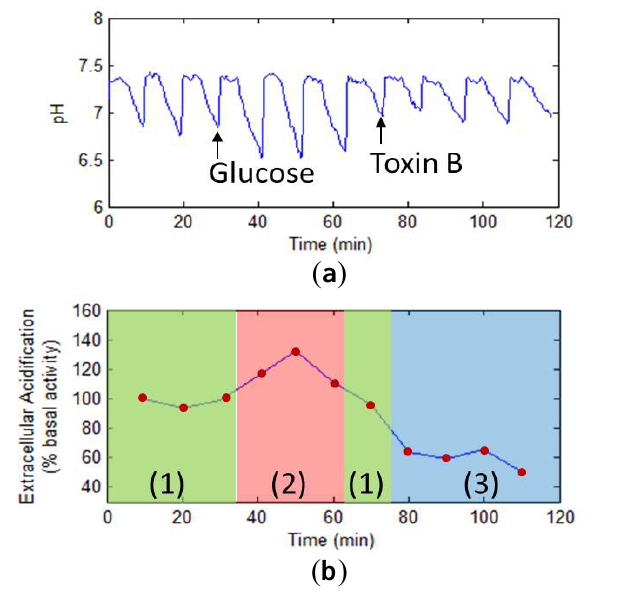
Figure 22. Cellular metabolism detection under drug stimulation. ( a ) Original data shows the change of pH corresponding to the photocurrent; ( b ) The extracellular acidification rate under the blank (1), glucose (2) and clostridium difficile toxin B (3). (Reprinted from [111]. © 2012, with permission from World Scientific Publishing